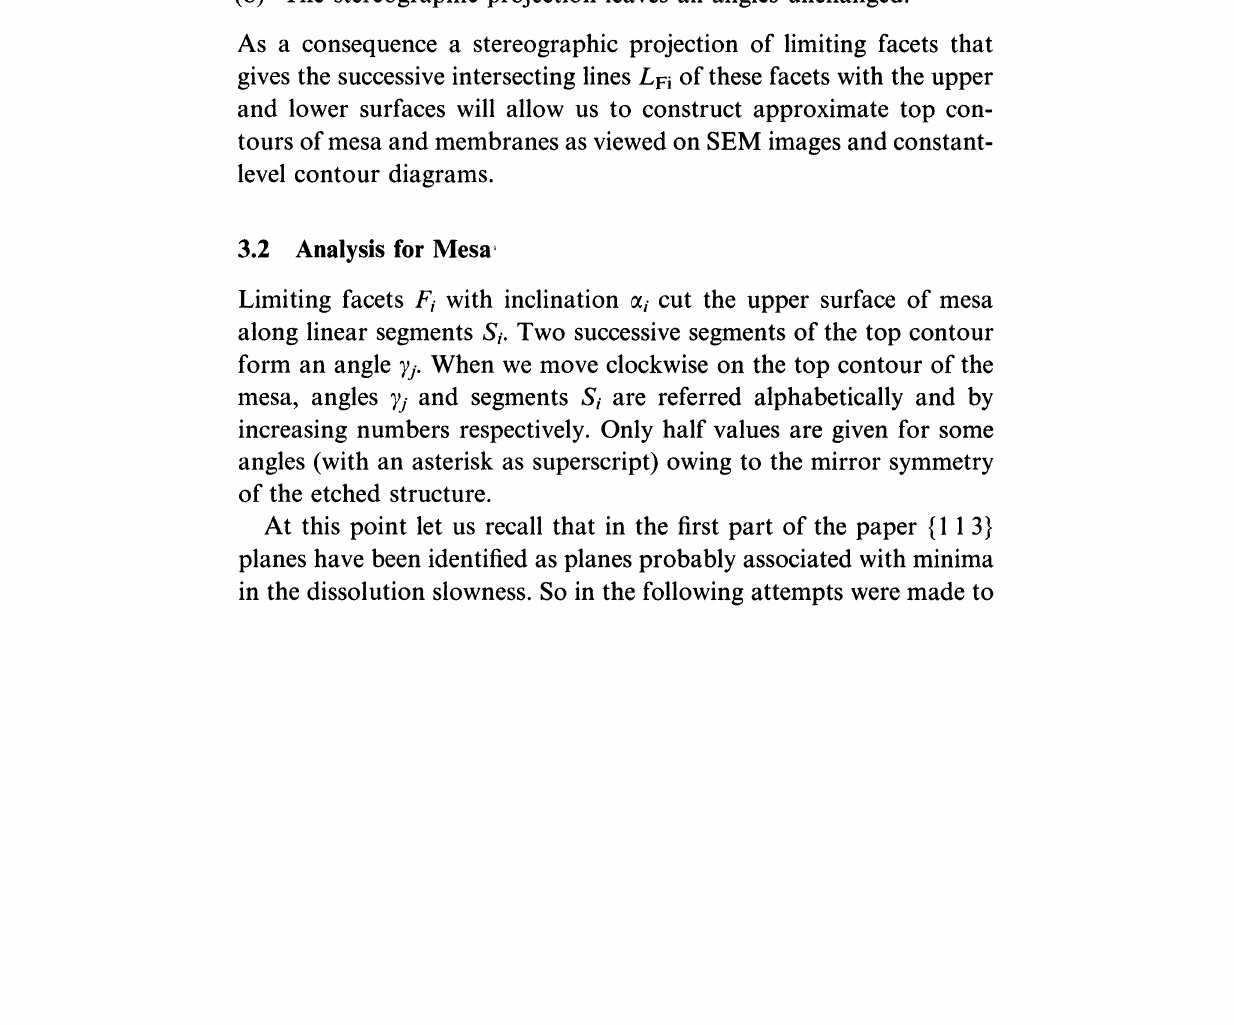
FIGURE 10 The stereographic